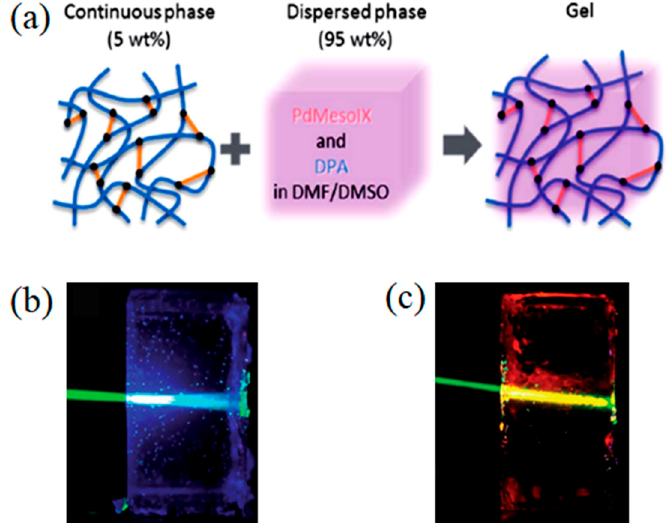
Figure 2. ( a ) Graphic representation of the structure of the upconverting organogel, ( b ) organogel containing both PdMesoIX and DPA pair showing green-to-blue triplet-triplet annihilation based photon upconversion (TTA-UC) emission upon 543 nm laser excitation under ambient conditions, ( c ) organogel containing only PdMesoIX showing no upconversion (UC) emission. Adopted with permission from [34]. Copyright 2015 Royal Society of Chemistry.